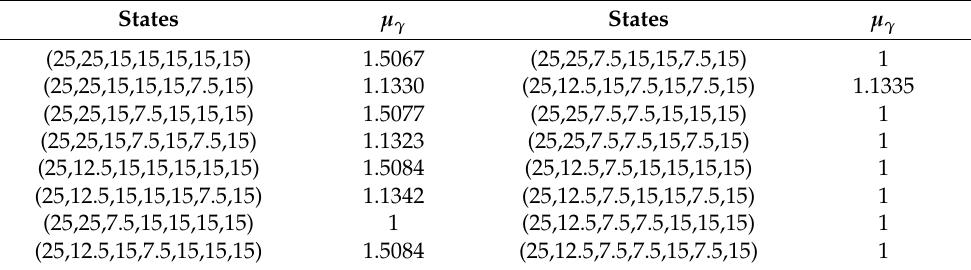
Table 9. List of reserve capacity in capacity status of each road section.